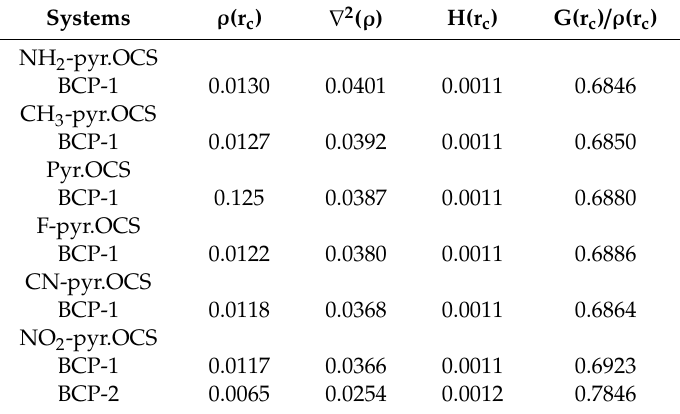
Figure 3. Atoms in Molecules (AIM) picture for the A , B , and C complexes of pyridine.OCS showing the existence of bond critical point (BCP). Table 3. Electron density ρ (r c ), Laplacian of electron density ∇ 2 ( ρ ), total energy H(r c ) and G(r c ) / ρ (r c ), values for bond critical point (BCP-1) and BCP-2 for the A -pyr.OCS complexes. All values are in a.u.